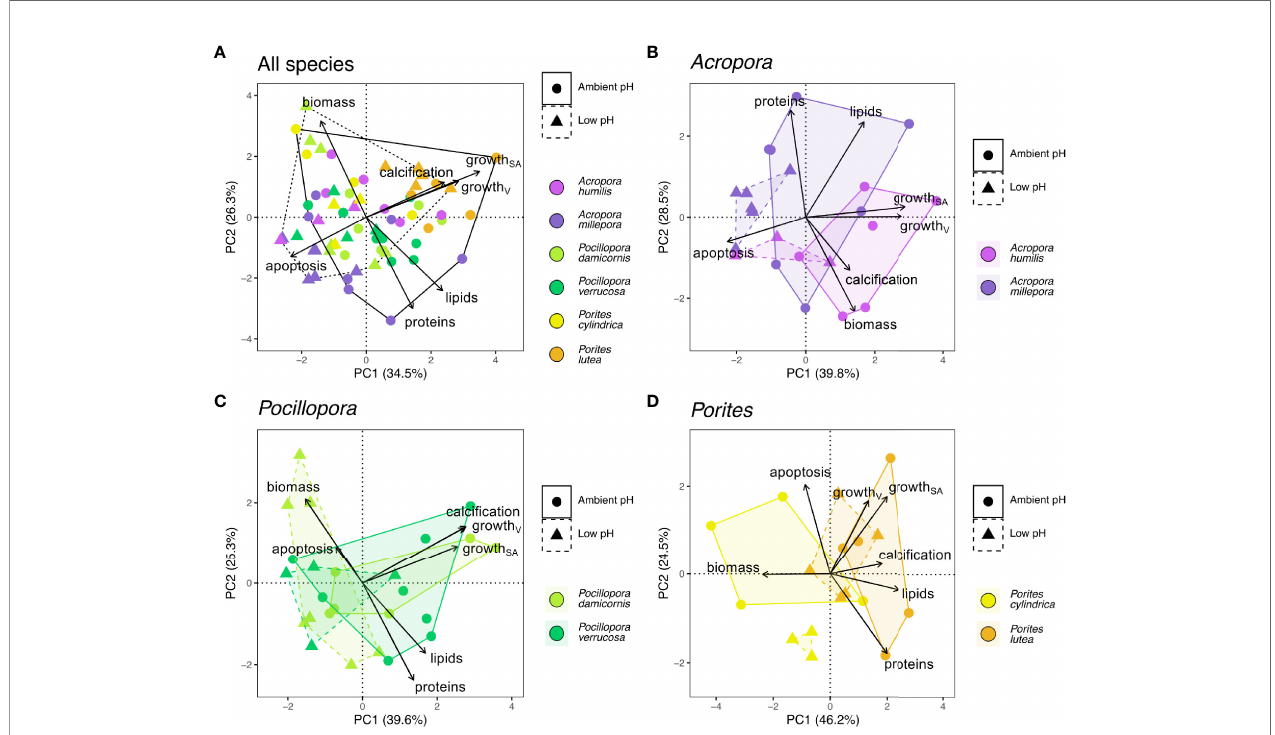
FIGURE 2 | Principal component analyses (PCA) using seven physiological parameters (calci fi cation; growth V , volume growth; growth SA , surface area growth; biomass, tissue biomass; lipids, lipid content; proteins, protein content; apoptosis, apoptotic activity) of six scleractinian coral species maintained in ambient and low pH treatments. PCAs were performed for (A) all coral species and for two species each in the genera (B) Acropora , (C) Pocillopora , and (D) Porites . Convex polygons outline ambient pH (solid line) and low pH (dashed line) treatments.